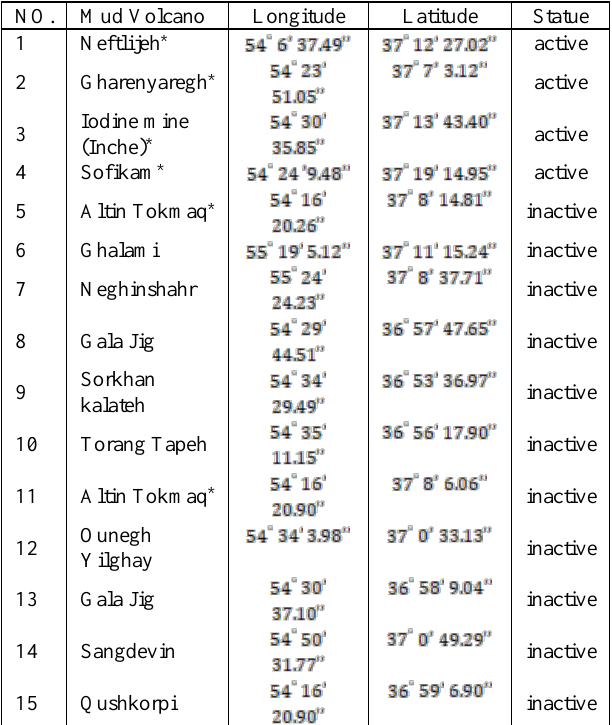
Figure 1 . The geographical location of the South Caspian Basin (a), the location of active and inactive volcanoes (b), as well as the schematic view of the cross-section of the active volcano and its mechanism of action are presented in parts (c) and (d) respectively (Kirkham, 2015).